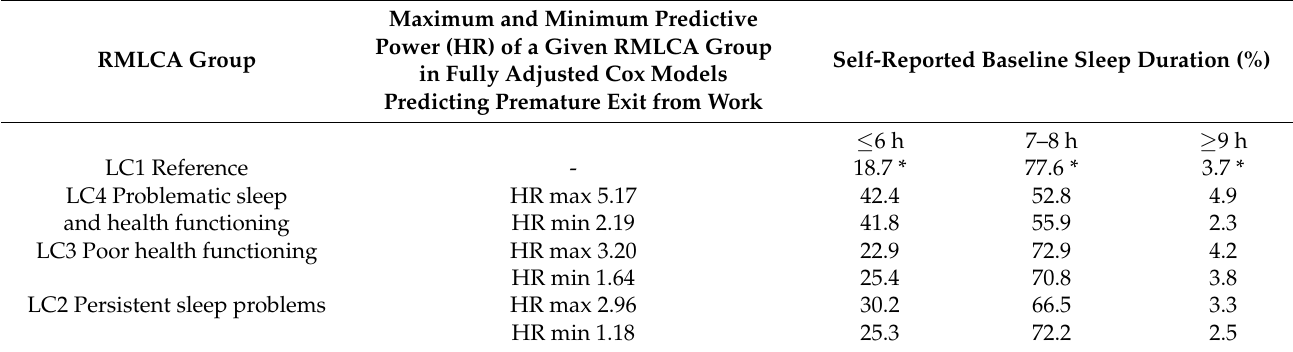
Table 5. Distribution of baseline sleep duration across RMLCA groups by their strength of association.